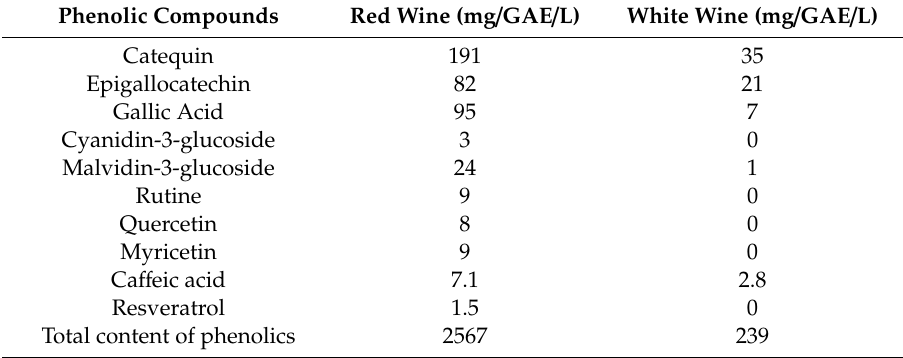
Table 1. Content of majority phenolic compounds of red and white wines, expressed in milligrams of gallic acid equivalent (mg / GAE / L). Adapted from Markoski MM, 2016 [33].